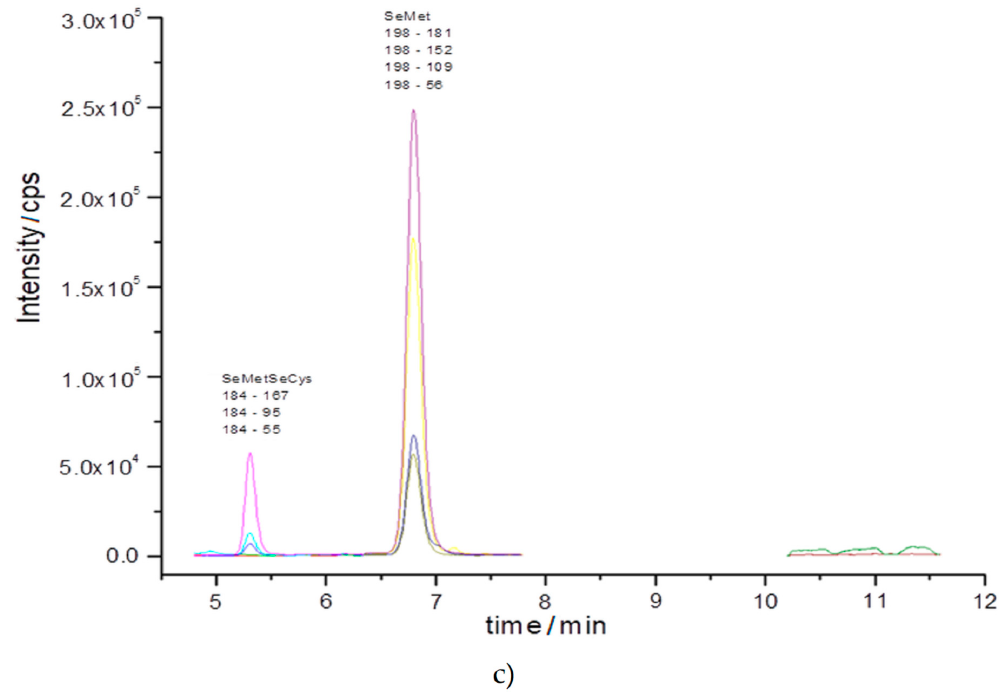
Figure 4. MRM chromatogram registered for extracts of ( a ) onion, ( b ) radish, and ( c ) sunflower Figure 4. MRM c hromatogram registered for extracts of (a) onion, (b) radish, and (c) sunflower sprouts grown in 60 mg Se/L medium (transitions precursor ion → product ion) by UHPLC-ESI- QqQ-MS/MS.